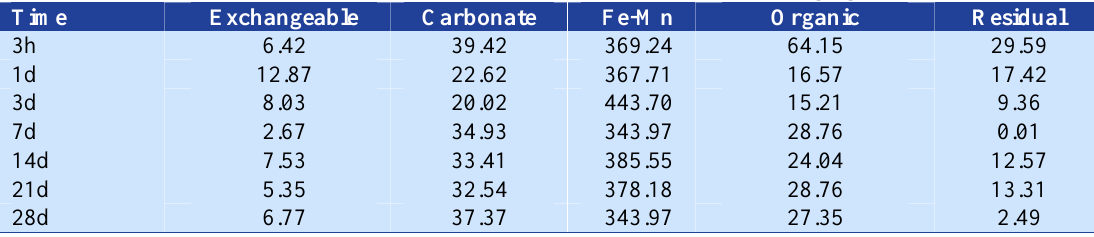
Figure 4. Different fractions of Zn in contaminated soil with silk worm cocoon (%) Table 5. Different fractions of Zn in contaminated soil with silk worm cocoon